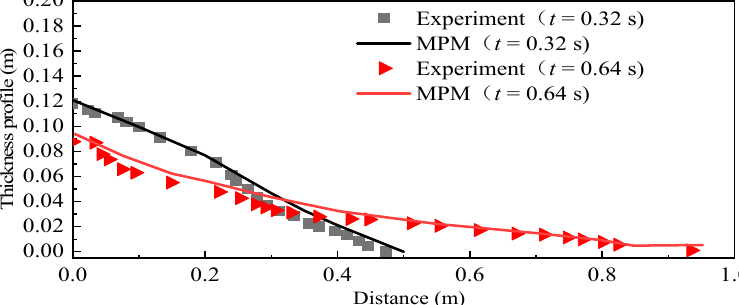
Figure 4. Snapshots for landslides sliding along erodible slopes.